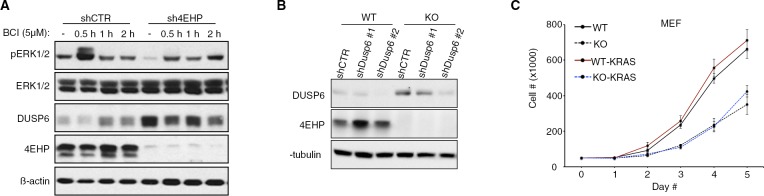
DUSP6-mediated repression of ERK activity and cell proliferation in 4EHP-depleted cells.(A) Time course analyses of BCI-treated control and 4EHP-knockdown U251 cells by WB for the indicated proteins. (B) WB for the indicated proteins in the control or Dusp6-knockdown WT and 4EHP-KO MEFs. (C) Cell proliferation assay. WT and 4EHP-KO MEFs, with stable expression of a constitutively active mutant KRAS (G12V) were seeded in 6-well plates. Cells were trypsinized after the indicated time points and cell numbers determined using a hematocytometer. Data are mean ± SD (n = 3).